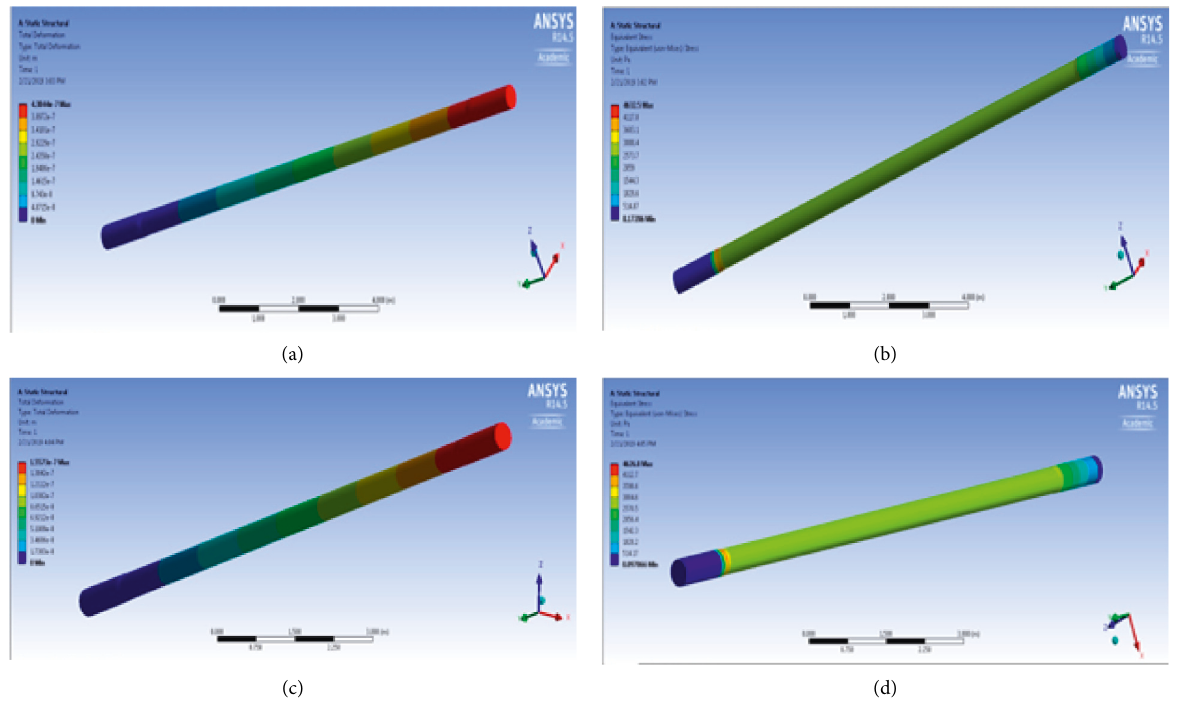
Figure 8: ANSYS workbench simulations of (a) (b) total deformation and von Mises stress of an aluminum alloy for the tensile load of 350N, (c) (d) total deformation and von Mises stress of steel for the tensile load of